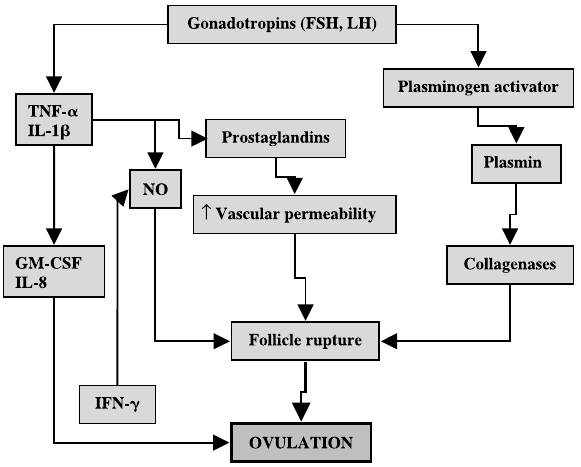
Figure 1. Hormones and cytokines involved in the process of